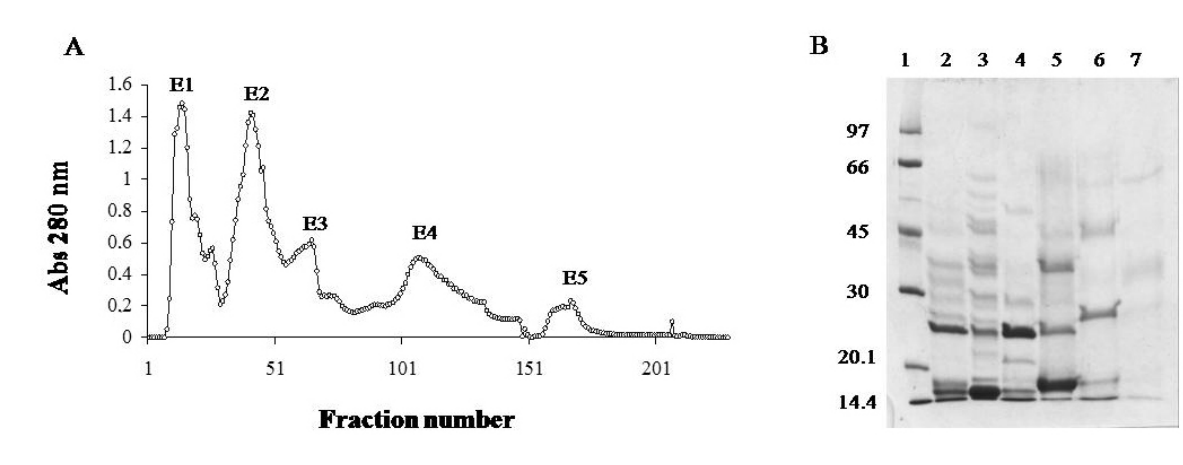
Figure 1. ( A ) Ion exchange chromatography on DEAE-Sephacel. B. moojeni crude venom (200 mg) was applied on the column (1.7 x 15 cm) and elution was carried out at a flow rate of 20 mL/hour with ammonium bicarbonate (Ambic) gradient buffer, pH 7.8, from 50 mM to 0.45 M. ( B ) SDS-PAGE (14%) gel in reduced condition of the fractions of the DEAE-Sephacel chromatography. Tris-glycine buffer, pH 8.3, and 20 mA. Lane 1: standard proteins; lane 2: Bothrops moojeni crude venom; lane 3: E1 fraction; lane 4: E2 fraction; lane 5: E3 fraction; lane 6: E4 fraction; lane 7: E5 fraction of B. moojeni venom. The gel was stained with Coomassie blue